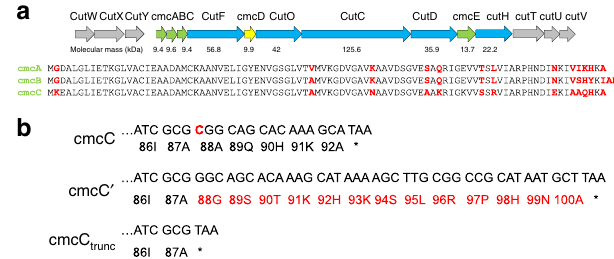
Fig. 1 Klebsiella pneumoniae GRM2 locus and variants of cmcC. a Klebsiella pneumonia GRM2 locus. Structural shell BMC-H proteins cmcA, cmcB, cmcC, and cmcE are colored in green, and BMC-P protein cmcD is colored in yellow. Core enzymes CutF (aldehyde dehydrogenase), CutO (alcohol dehydrogenase), CutC (choline lyase), CutD (glycyl-radical activating enzyme), and CutH (phosphotransacylase) are colored in blue. Regulatory and transporter genes are colored in gray. The genes have been named according to previous research 15 . b C-terminal amino acid sequences of three cmcC variants — cmcC (native), cmcC ′ (mutated), and cmcC trunc